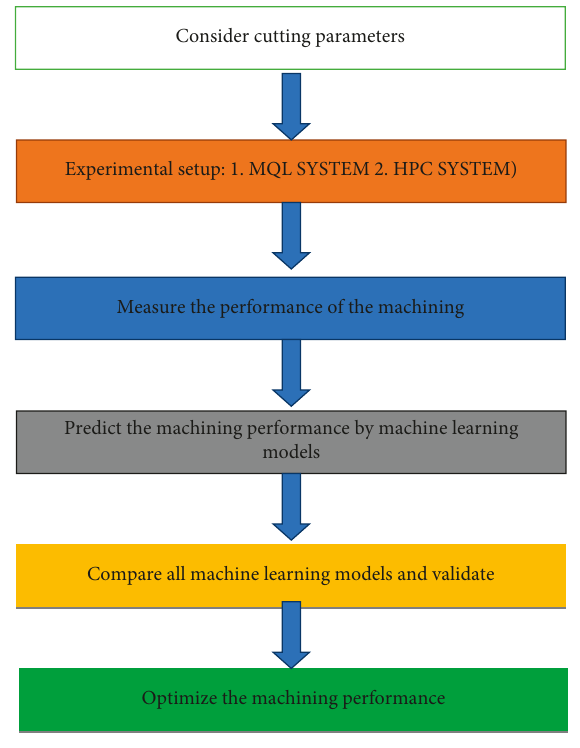
Figure 1: Flow chart machining parameters and